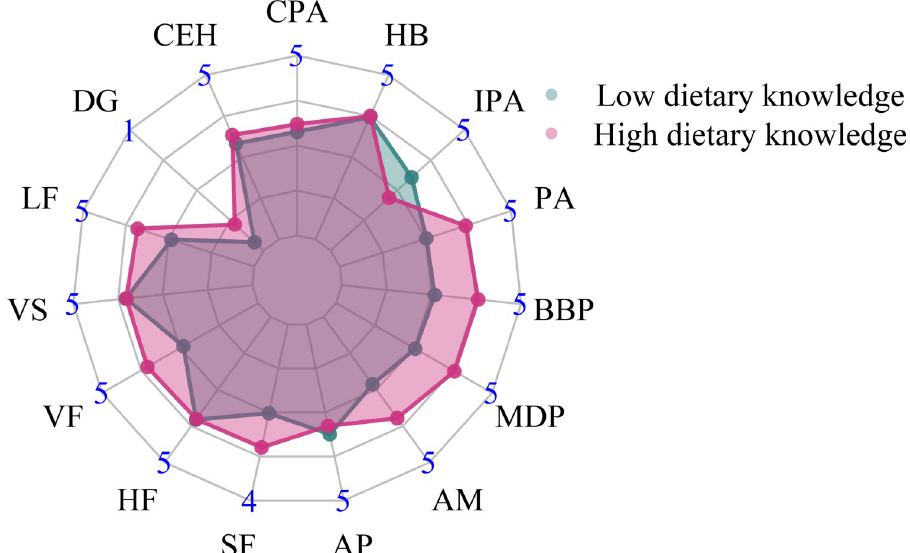
Fig 3. Radar plot for dietary knowledge of mothers. DG: Do you know about the dietary guidelines for Chinese residents? LF: Choosing a diet with a lot of fresh fruits and vegetables is good for one’s health. VS: Eating a lot of sugar is not good for one’s health. VF: Eating a variety of foods is good for one’s health. HF: Choosing a diet high in fat is not good for one’s health. SF: Choosing a diet with a lot of staple foods (rice and rice products and wheat and wheat products) is not good for one’s health. AP: Consuming a lot of animal products daily (fish, poultry, eggs and lean meat) is not good for one’s health. AM: Reducing the amount of fatty meat and animal fat in the diet is good for one’s health. MDP: Consuming milk and dairy products is good for one’s health. BBP: Consuming beans and bean products is good for one’s health. PA: Physical activities are good for one’s health. IPA: Sweaty sports or other intense physical activities are not good for one’s health. HB: The heavier one’s body is, the healthier he or she is. CPA: the priority of “having my child be physically active” in your life. CEH: For mothers: the priority of “having my child eat a healthy diet” in your